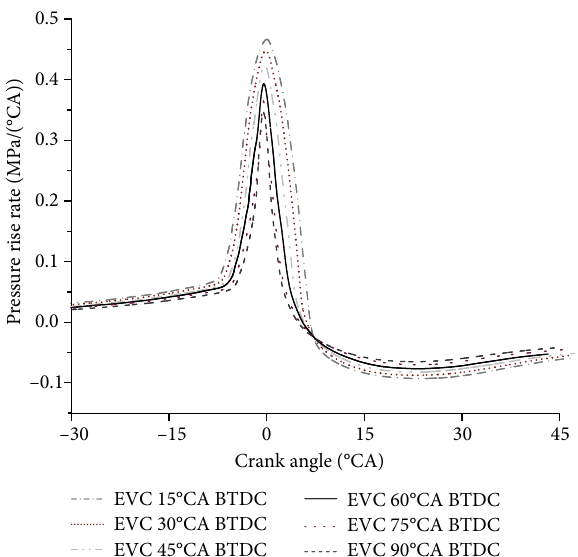
Figure 11: In fl uence of advanced EVC on NO